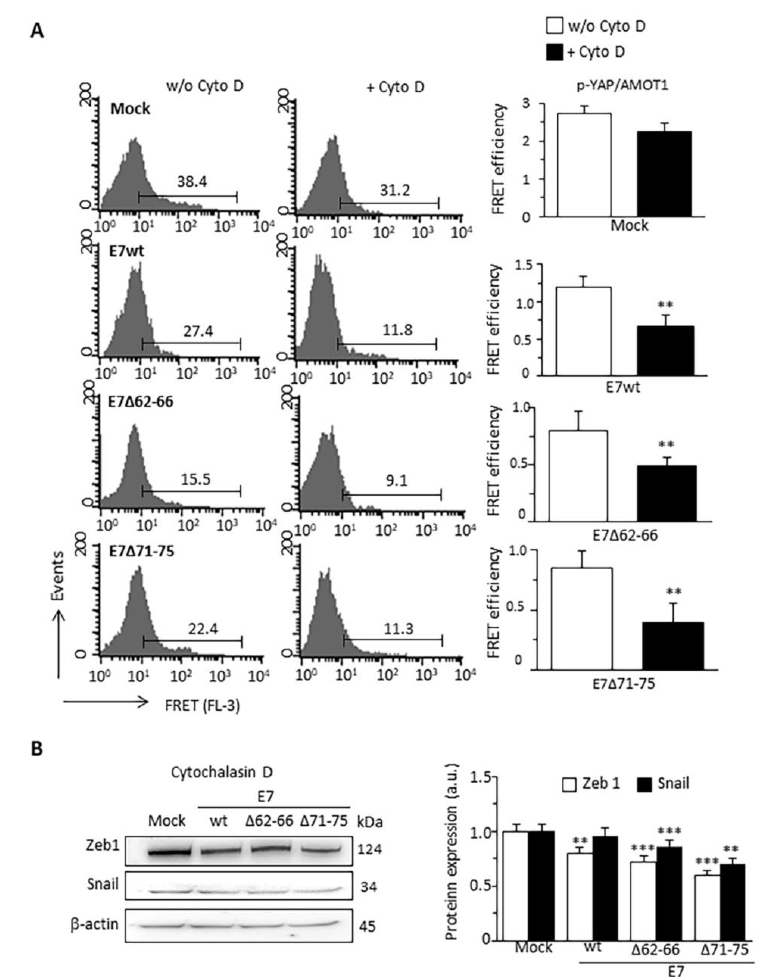
Figure 6. Effect of Cytochalasin D on p-YAP/AMOT1 interaction and expression of EMT markers. ( A ) Quantitative evaluation of p-YAP/AMOT1 molecular association by FRET technique, as revealed by flow cytometry analysis restricted to pAmCyan-positive cells treated or not with CytoD (1 mM for 4 h). Numbers indicate the percentage of FL3 positive events obtained in one experiment representative of three. Bar graphs on the right show FRET efficiency calculated according to the Riemann's algorithm. Data are reported as mean ± SD from three independent experiments. ** p < 0.01 vs. Mock transfected cells. ( B ) Western blot analysis of the expression of the EMT markers Zeb1 and Snail in C33A expressing E7wt or E7 mutated treated with CytoD. β -actin determination was used as loading controls. Bar graph (right) shows relative densitometry quantitation of each protein normalized to β-actin obtained in three independent experiments and reported as mean ± SD. ** p < 0.01, *** p < 0.001 vs the same sample treated with CytoD. Uncropped western blot images for Figure 6B are available in Supplementary Figure S9.